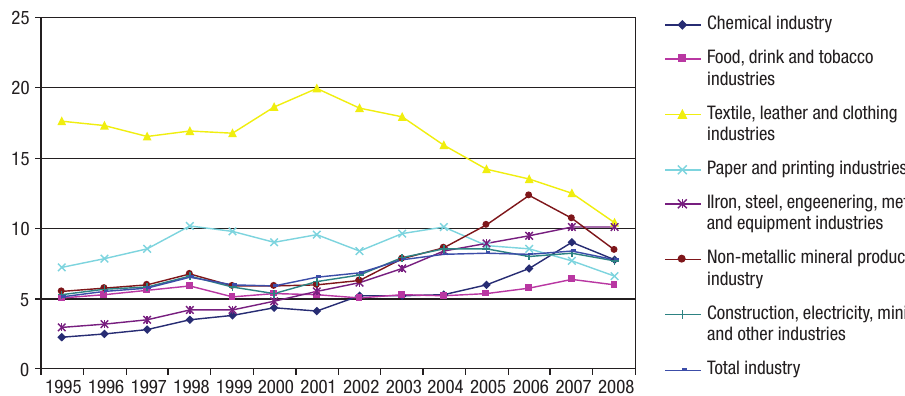
Fig. 6. Capital productivity of Lithuania‘s industrial sectors during 1995–2008 Source : Data from EUROSTAT, index calculated by authors (capital productivity is as a ratio of output per fi xed capital consumption, an input; where capital productivity = Gross Value Added, EUR / Consumption of fi xed capital,